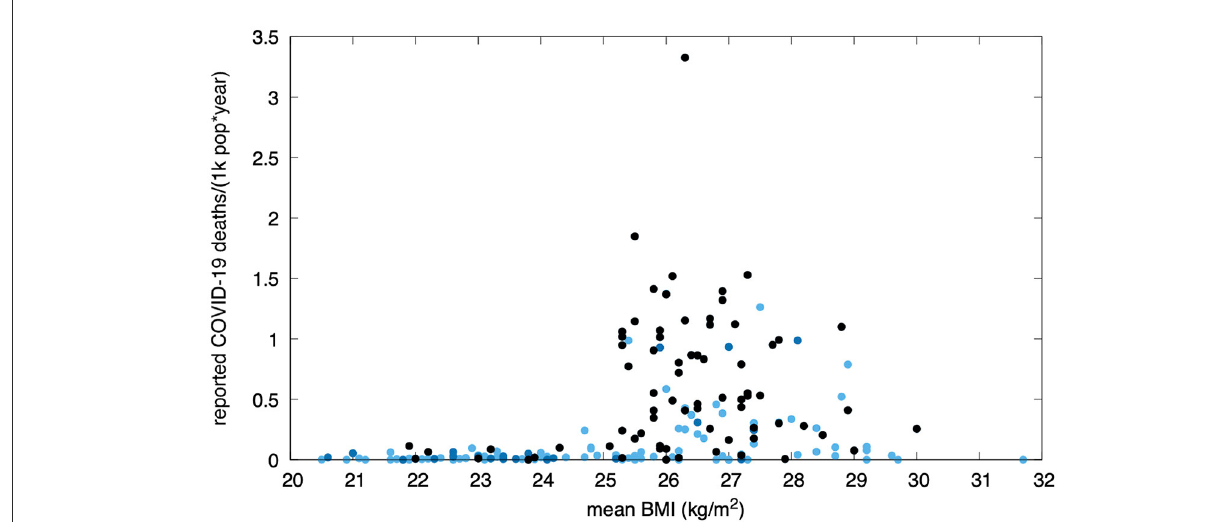
FIGURE2 Pre-vaccination annual reported COVID-19 mortality in 183 countries (Our World in Data, year 2020) vs. mean BMI. Black dots correspond to countries who performed more than 50 tests per thousand people per year. Dark blue dots indicate countries who did not reach such a rate. Countries for which testing data was not available within this dataset are shown in light blue. The lower mortality rates among countries with a normal mean BMI can not be explained by undertesting alone (a few extensively-testing countries can be seen in this range).